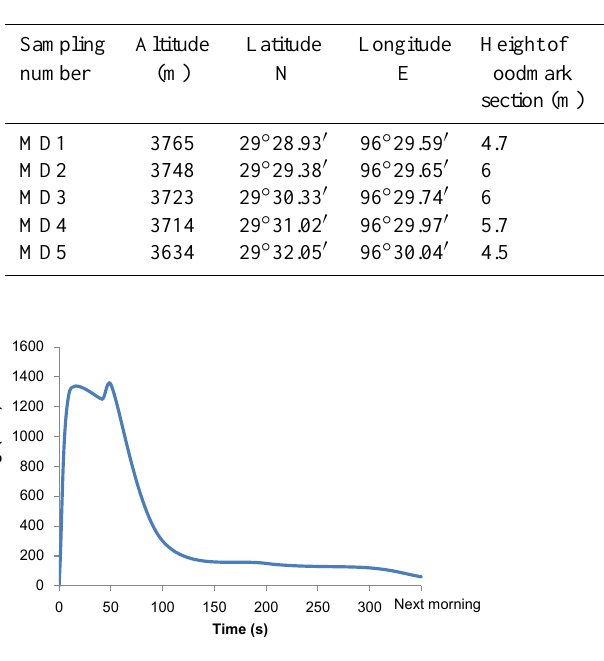
Table 2. Five soil-sampling sites in Midui Valley.